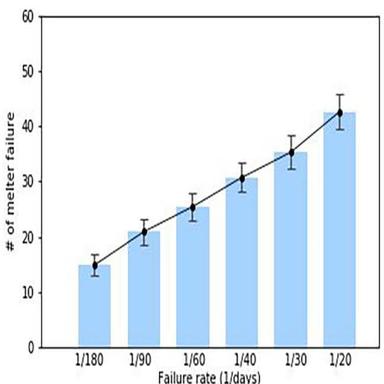
4. With the failure rate parameter of 1/180 days, the average number of melter failure is 15 ± 2.0. The following average numbers of melter failure given the failure rate parameters of 1/90 days, 1/60 days, 1/40 days, 1/30 days, and 1/20 days are obtained as 21 ± 2.3, 25 ± 2.5, 31 ± 2.6, 35 ± 3.0, and 43 ± 3.1.